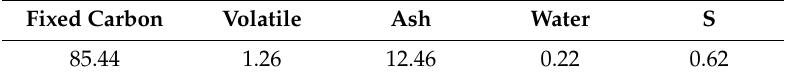
Figure 1. XRD pattern of phosphorite. Table 1. Chemical compositions of coke (mass%).